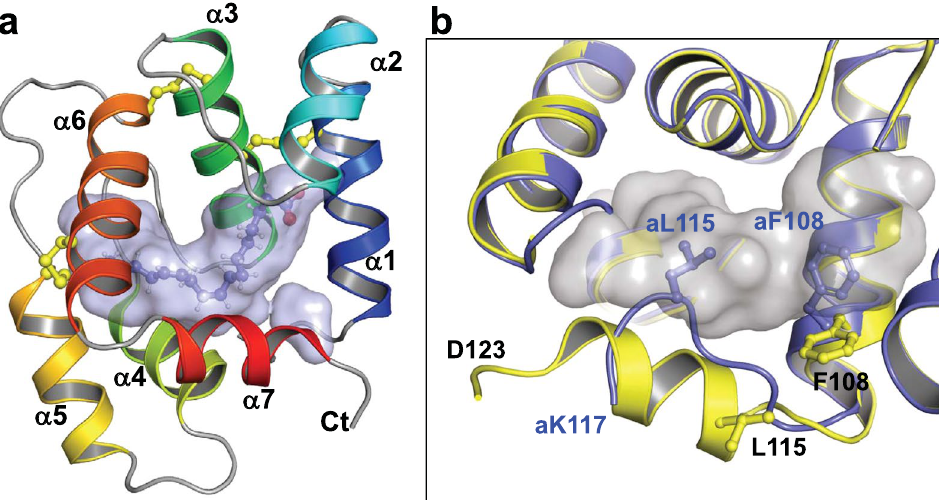
Figure 2. Structure of AeOBP22. (a) Ribbon diagram of the AeOBP22-linoleic acid complex solved by X-ray crystallography at 1.85 Å. Helices are color coded from blue to red, N to C terminus. The binding pocket is shown as a surface representation and linoleic acid is shown as sticks. (b) Comparison of the C-terminal tail in the linoleic acid complex (yellow) and in the apo-state (blue). In apo AeOBP22, L115 and F108 insert into the pocket (shown in grey) to occlude binding of larger ligands. Reside numbers for the apo-state are preceded with an “a”. Residues 118–123 of the apo-state are not observable in the